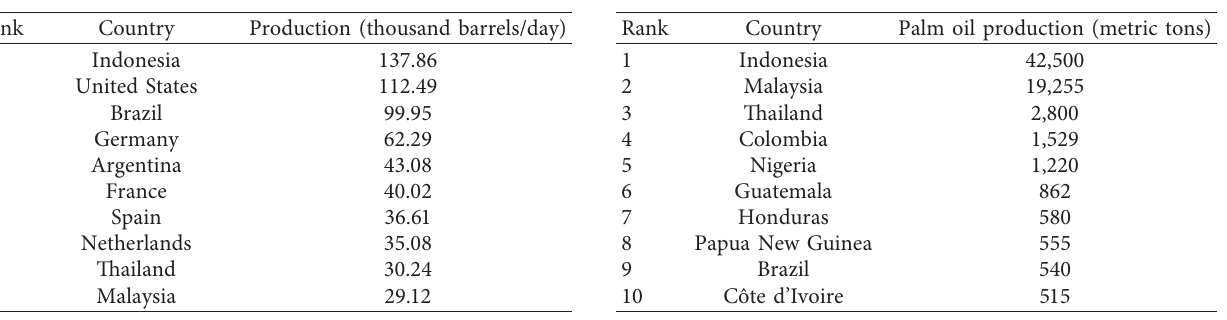
Table 6: List of countries with the highest biodiesel production in the world [139].